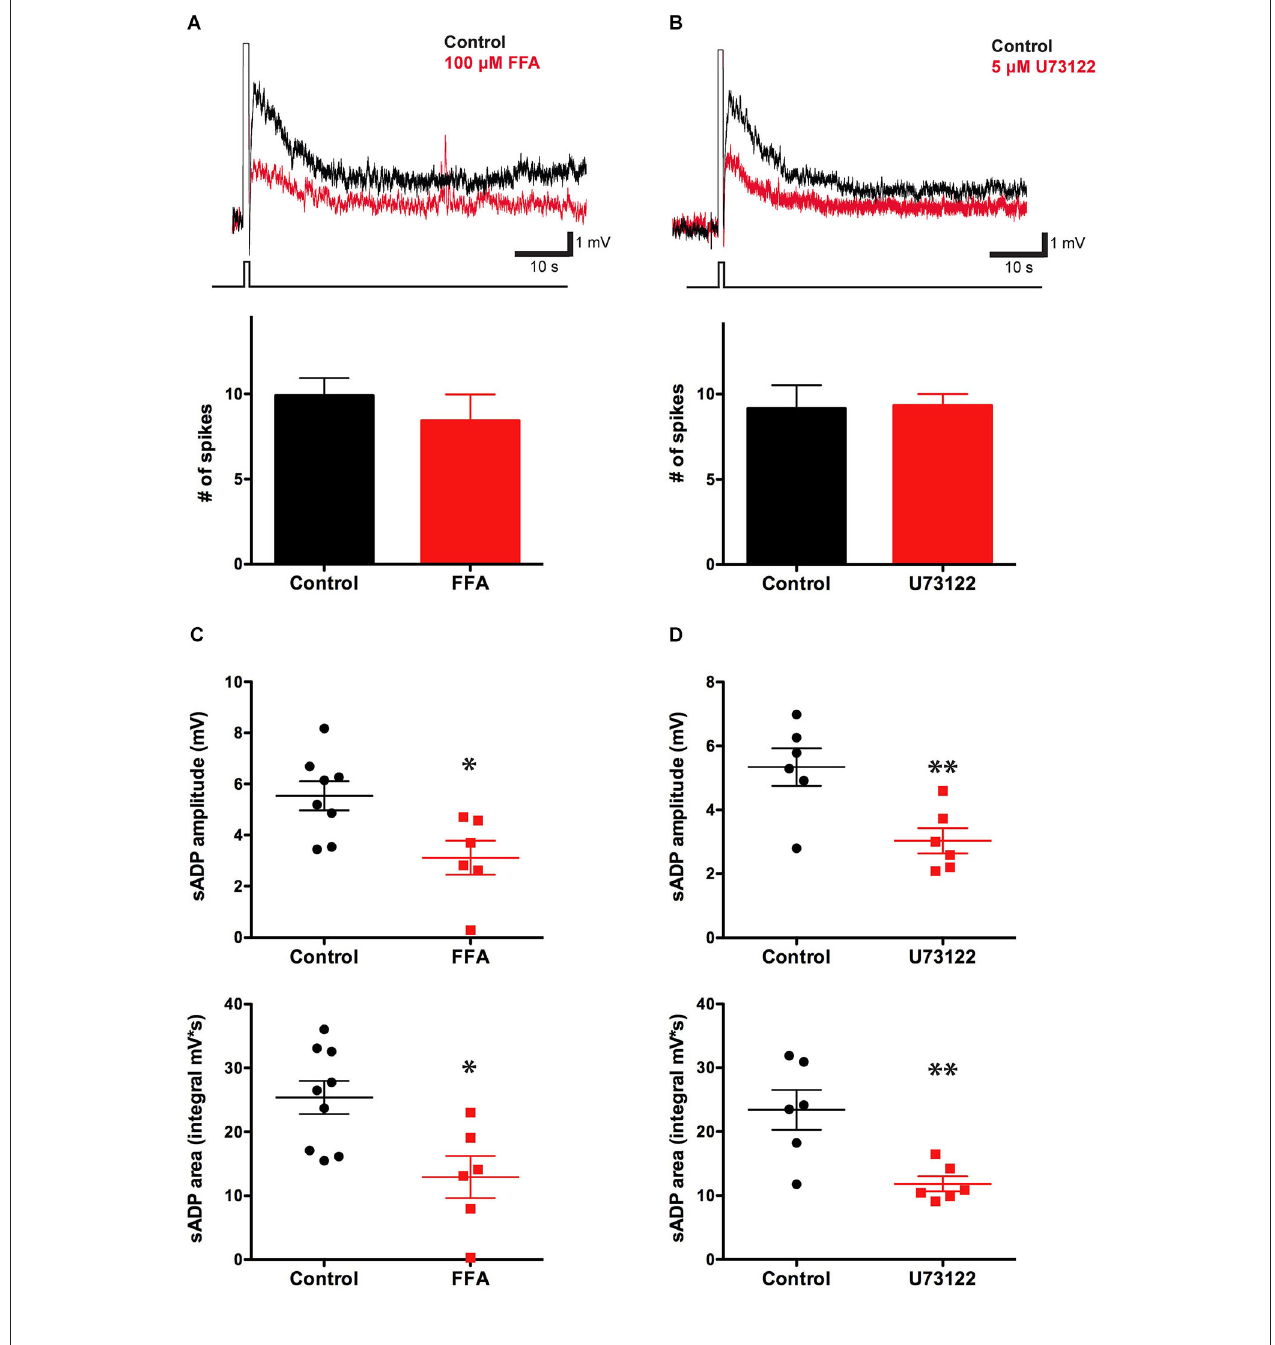
sADP induced by a depolarizing current step (bottom trace) in CCh under control conditions (black trace) or with 5 µ M U73122 in bath (red trace). Initial V m was − 65 mV. Number of spikes during the depolarization (200 pA for 500 ms) was not affected by U73122 ( n = 6, P = 0.91). (C) FFA decreased the sADP amplitude ( n = 6–8, * P < 0.05) and area ( n = 6–9, * indicates P < 0.05). (D) The PLC blocker U73122 decreased the sADP amplitude ( n = 6, ** indicates P < 0.01) and area ( n = 6, ** indicates P <